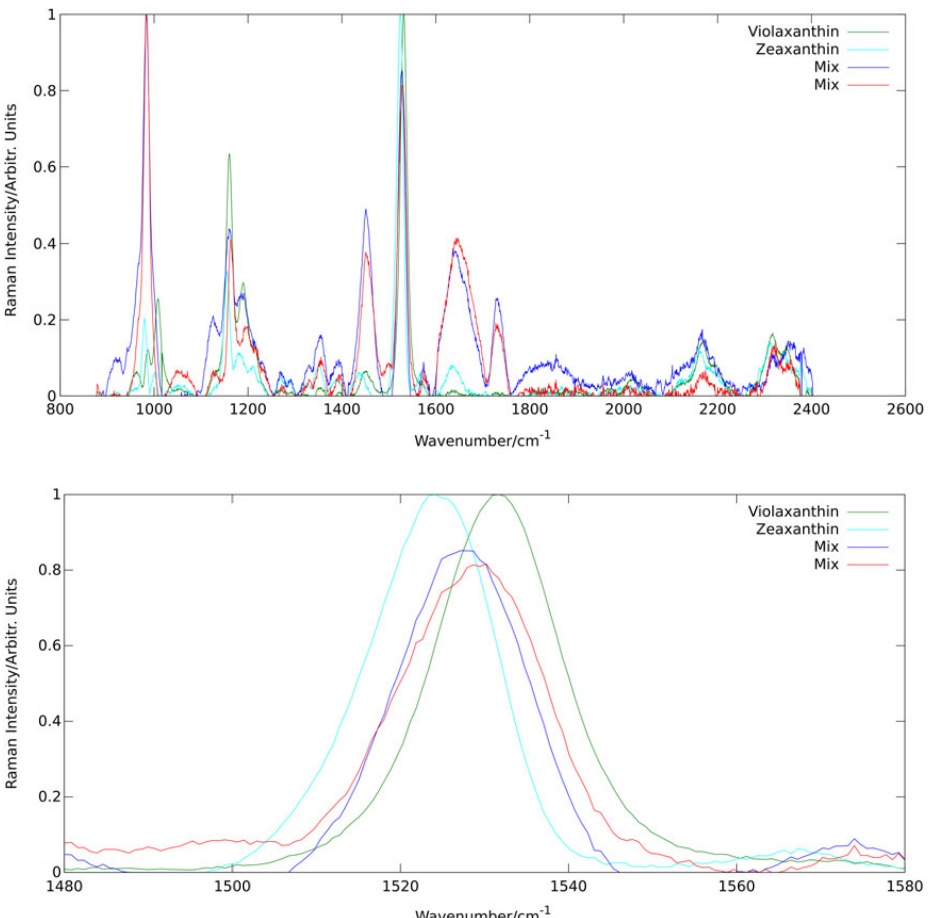
Figure 7. The first four principal components as analyzed by PCA from spectra of an algae culture ( top ). Analysis of major line positions such as the C=C stretch vibrations ( bottom ) sometimes allows assignment of certain molecules as the origin of the respective principal component (reproduced with permission from